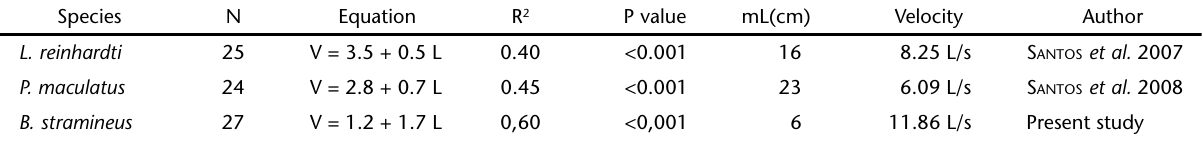
Table I. Statistical aspects of known critical speed curves for neotropical species, and velocity (lengths per second) for the first maturation total length (ml).